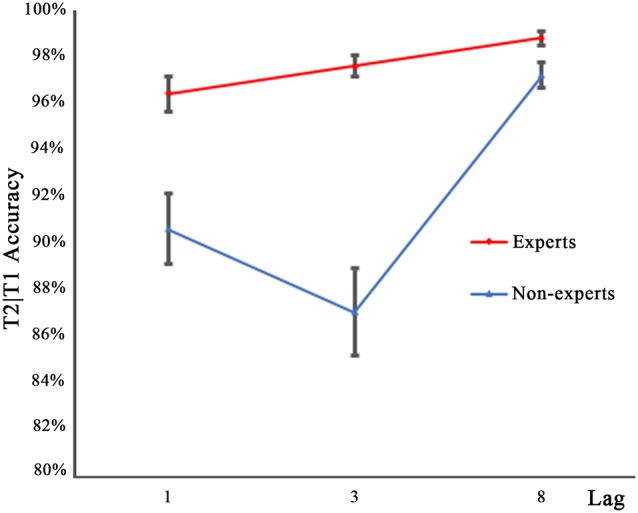
Mean accuracy for identifying T2 in the three lag conditions of experts and non-experts when T1 was correctly identified. Error bars stand for SE.